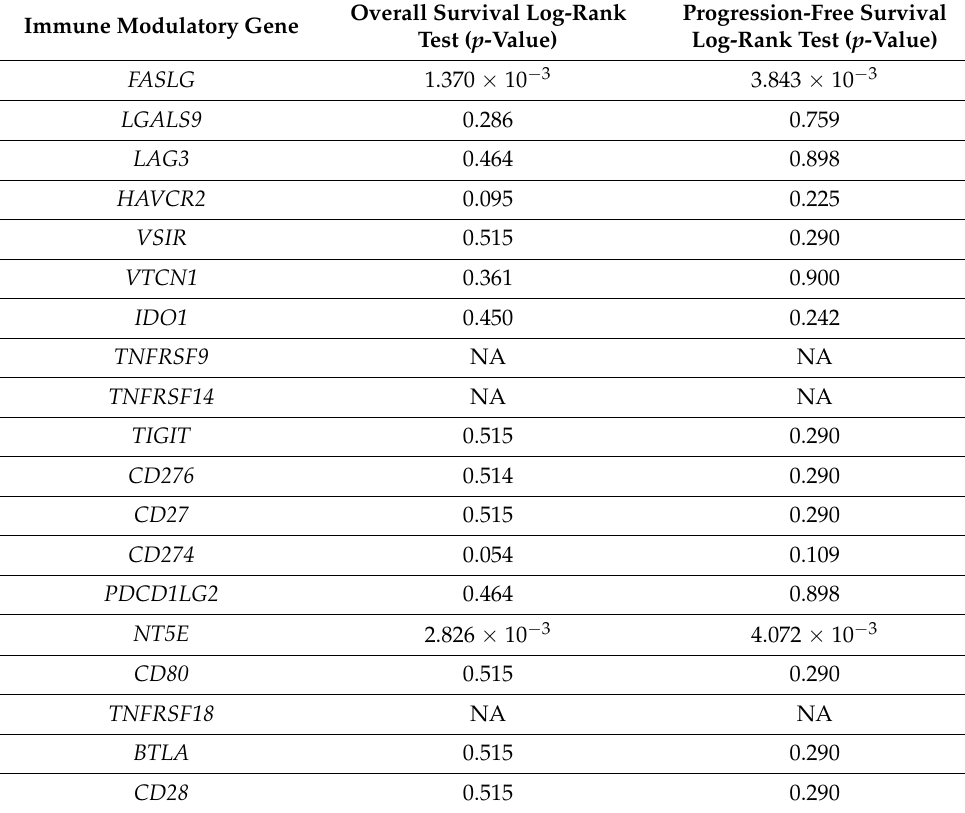
Table 5. cBioPortal-based CCA patient overall survival and progression-free